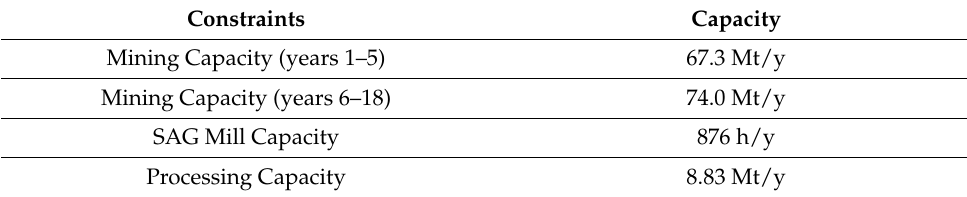
Table 2. Capacity constraints.